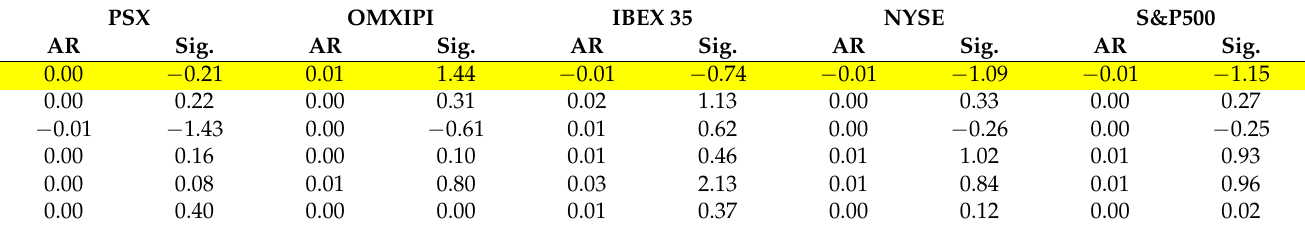
Table A24. Abnormal returns of the (0, +5) event window (Jurgen Mossack